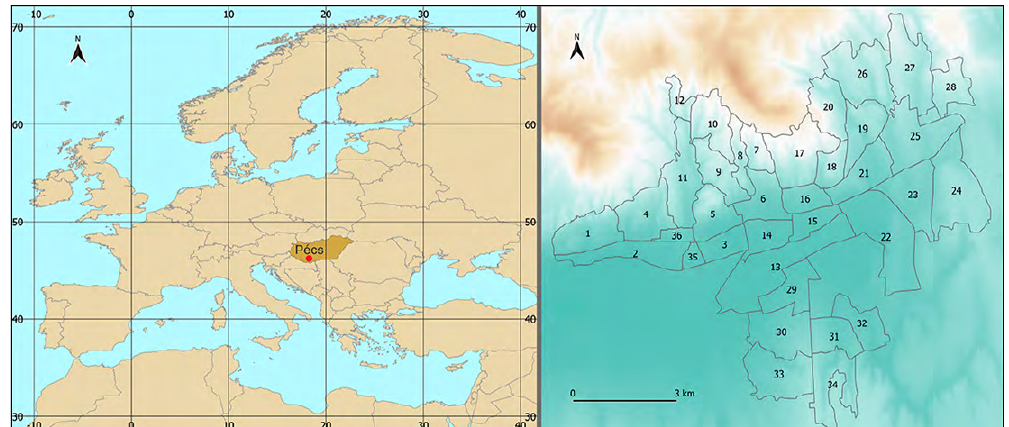
Figure 1. Location of Pécs in Europe (A) and its neighbourhoods